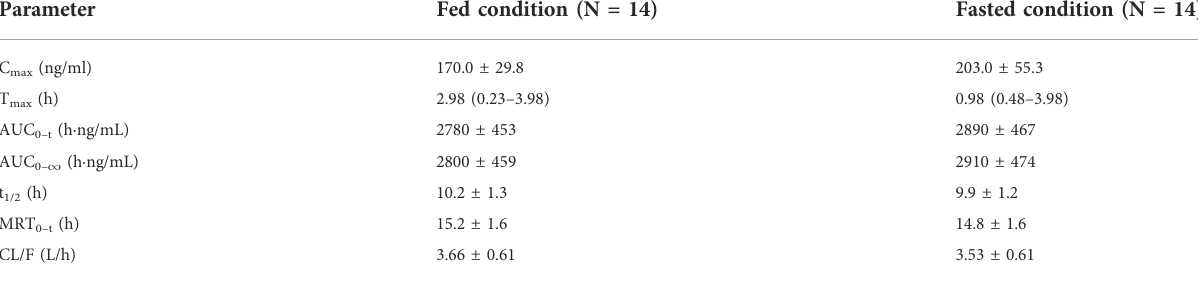
TABLE 2 The primary pharmacokinetic parameters of WXFL10203614 after dosing under fed and fasted conditions.